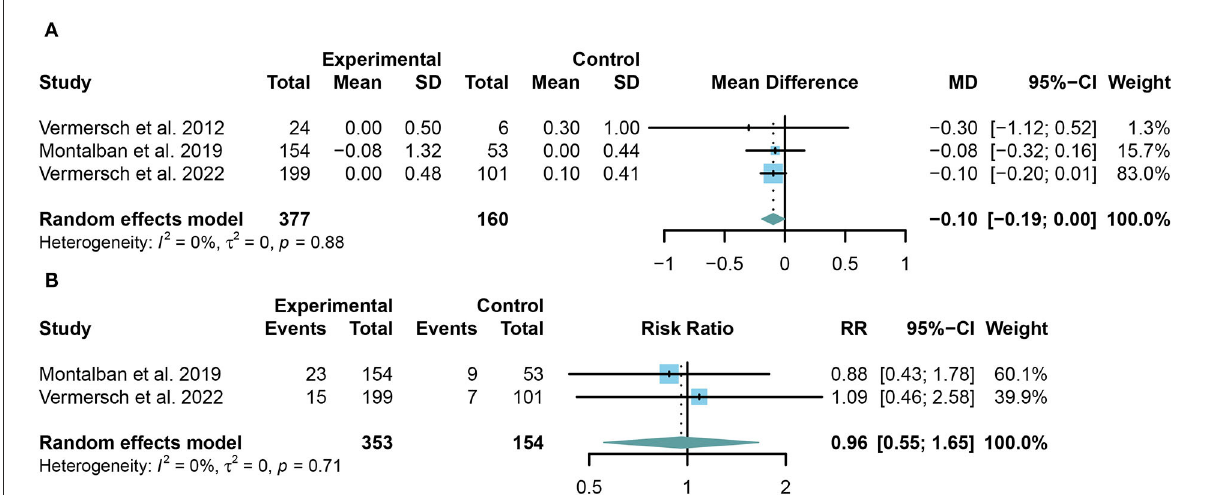
FIGURE3 (A) The pooled mean differences (MDs) of the change in the expanded disability status scale (EDSS) score compared with the placebo group; (B) the pooled risk ratios (RRs) of the relapse rate of multiple sclerosis compared with the placebo group, the diamond indicates the estimated summary MD or RR with 95% confidence interval (CI).